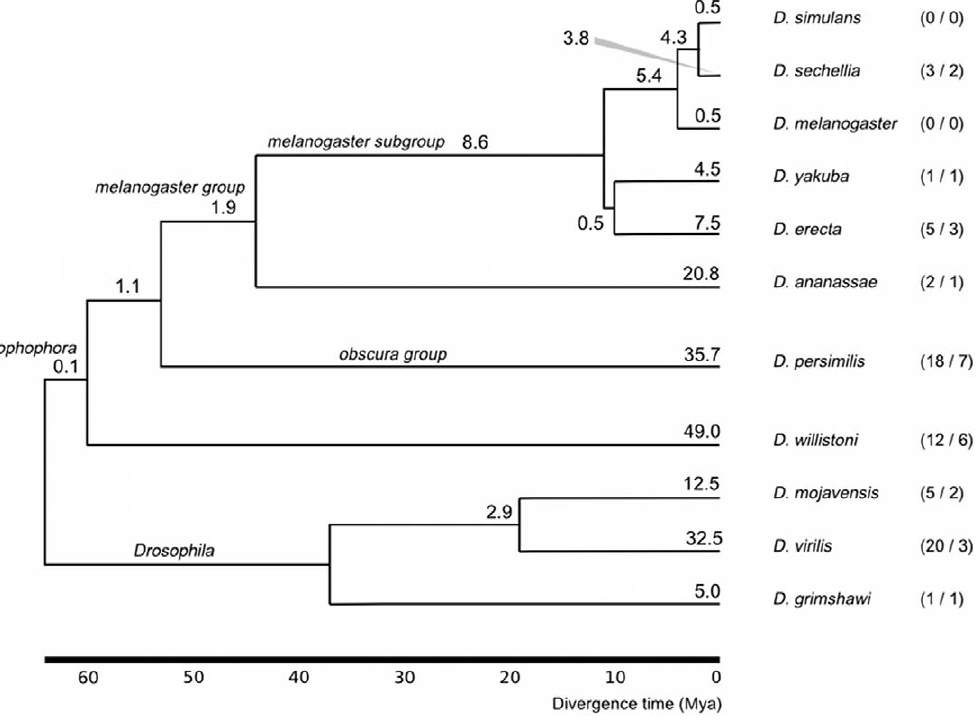
Figure 2. Age of numt insertions. Average frequencies (insertions per million years) of numt insertions on each branch of the Drosophila tree are shown. In parentheses is the number of extant numts that have arisen by duplication (left), and the number of distinct paralog sets (right). Divergence times were derived from TimeTree [47] and the tree toplogy from [20]. doi:10.1371/journal.pone.0032593.g002 PLoS ONE |